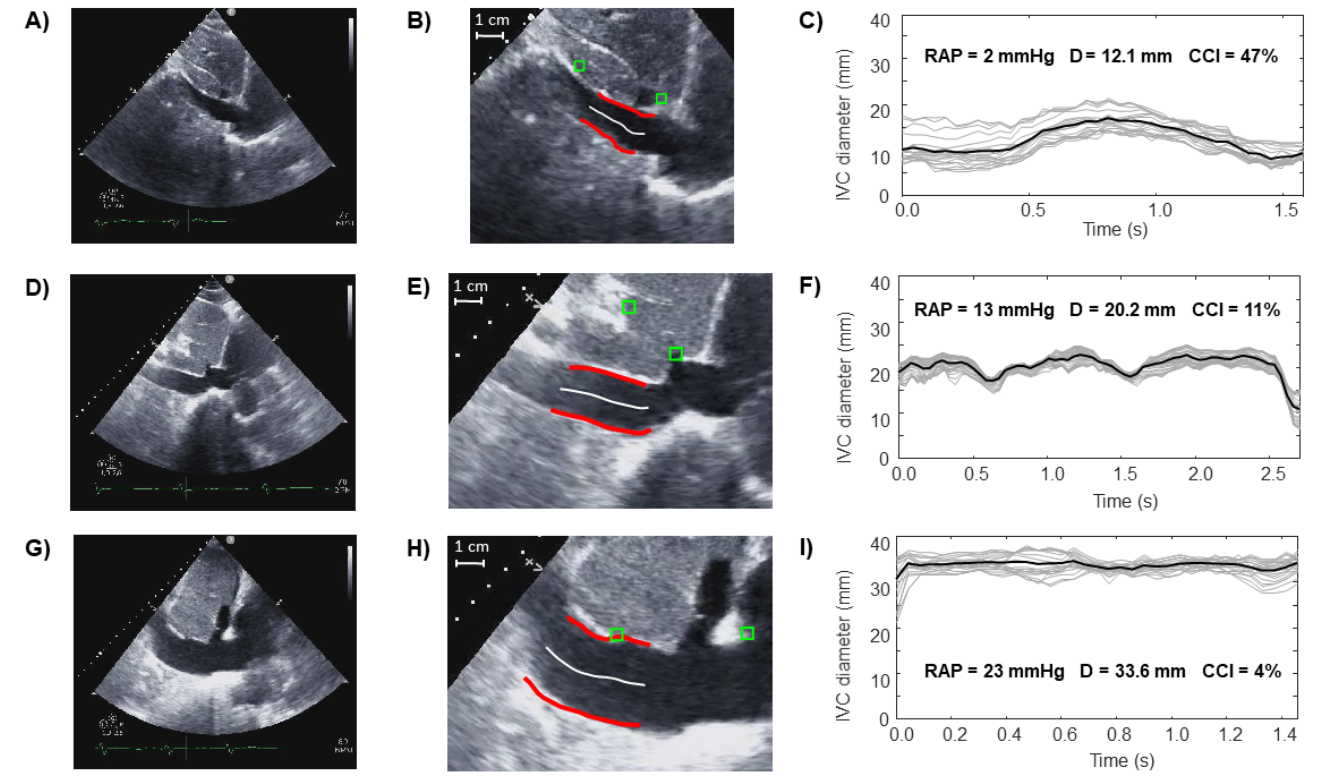
Figure 1. Examples of US video frames of three subjects ( A – I ), IVC borders and midline highlighted in red and white, respectively, ( B , E , H ) and vessel diameters over time ( C , F , I ) obtained by the semi- automated algorithm, together with the values of CCI, mean diameter, and RAP. The three subjects belong to different RAP classes: low ( A – C ), intermediate ( D – F ), or high ( G – I